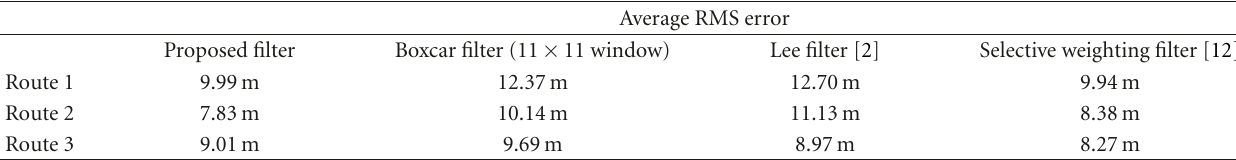
Table 2: Average root mean square (RMS) error